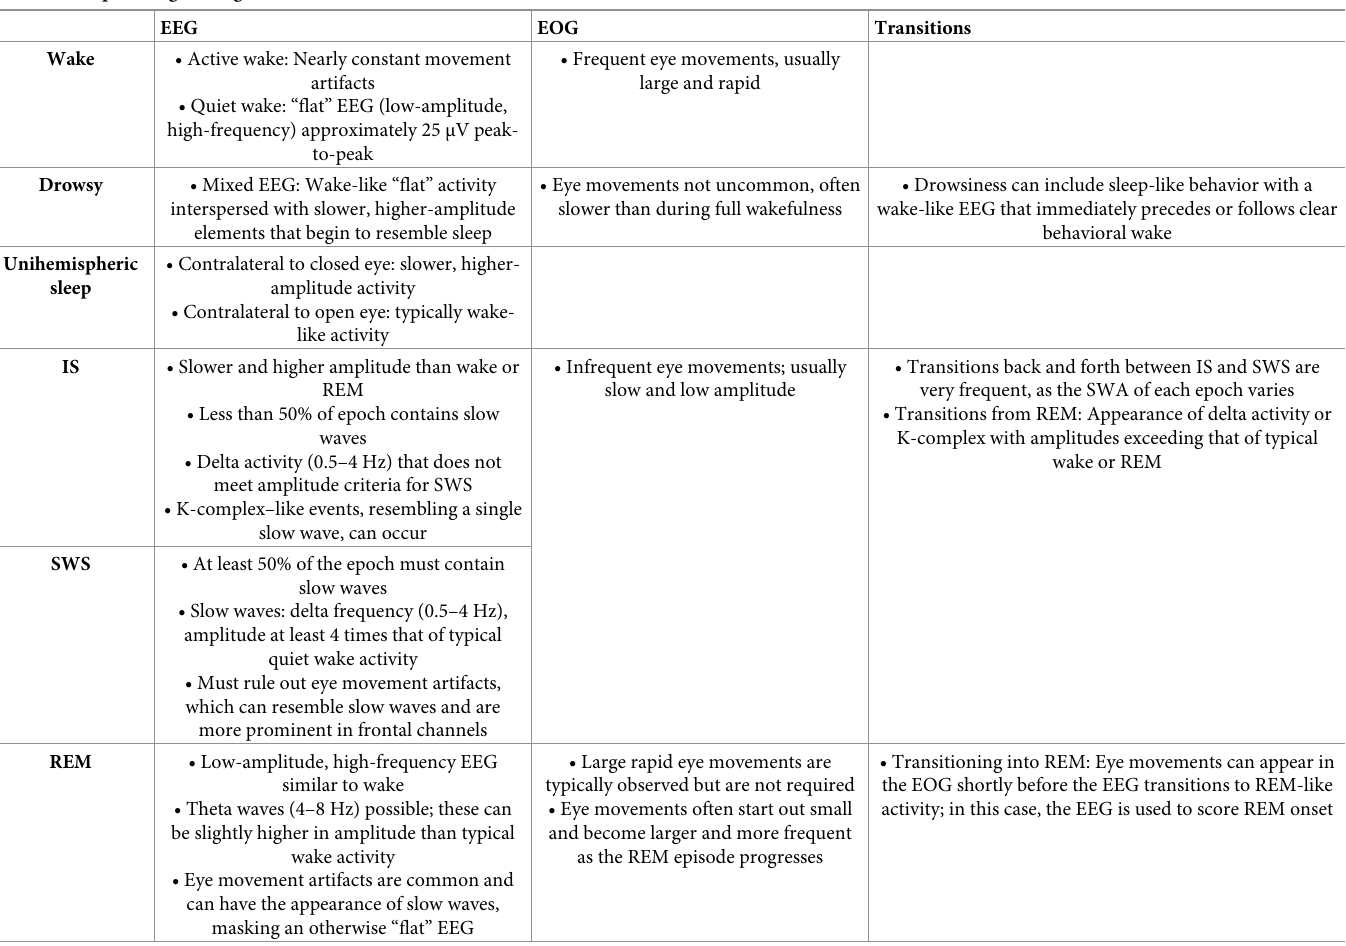
Table 4. Sleep scoring and vigilance state